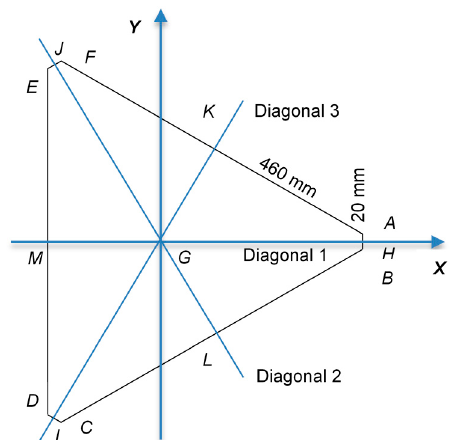
Figure 16. Plan view of the shell: reference point G (geometric centre), and the diagonal cross-sections defined by the planes MGH , JGL and IGK .